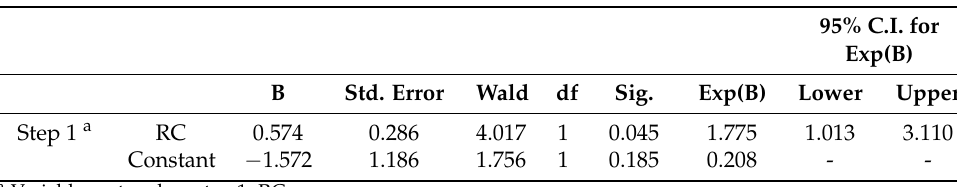
Table 24. Regulatory compliance: regression analysis for PaaS.